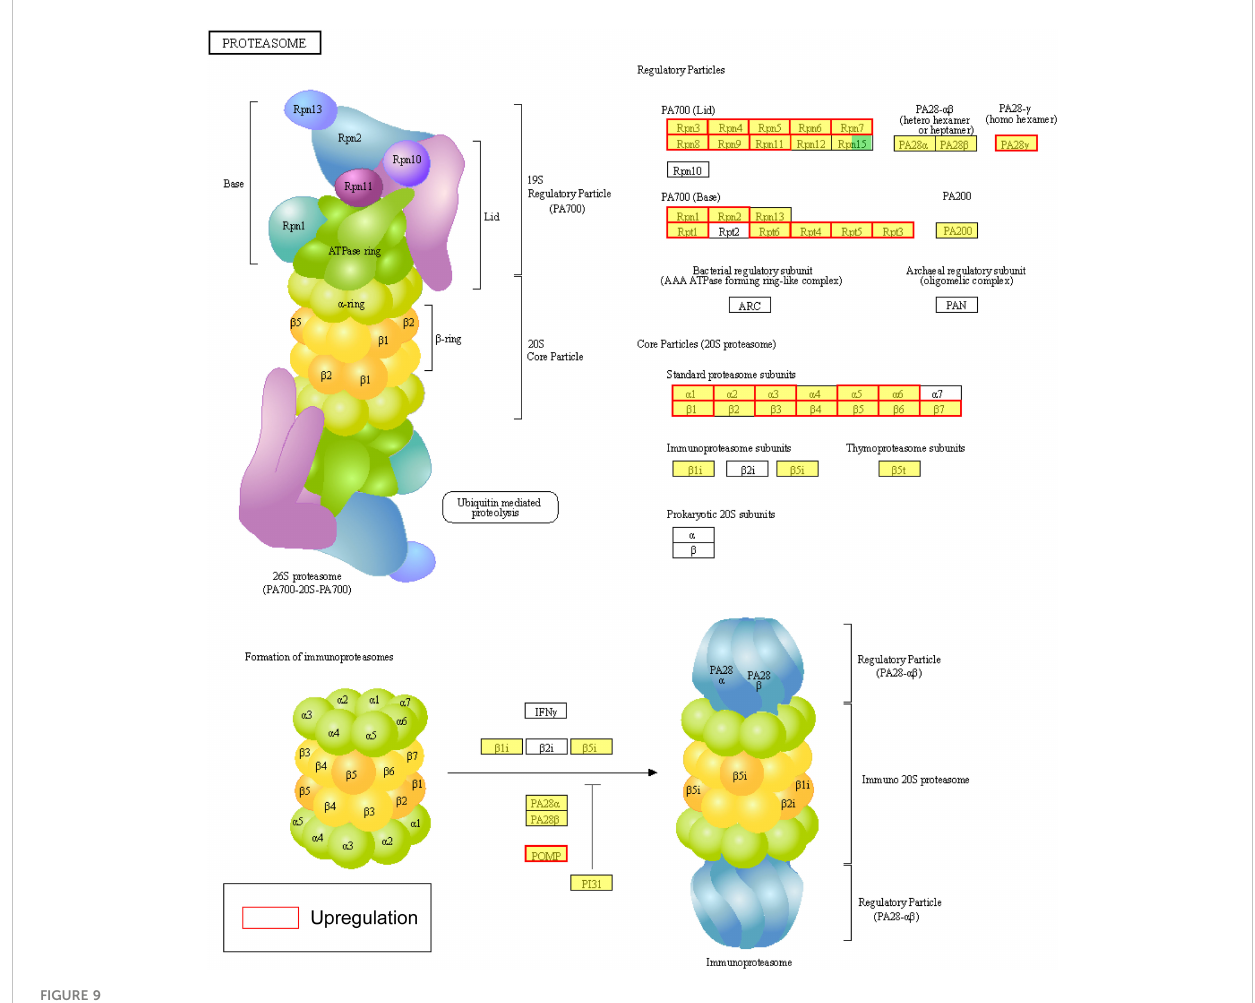
FIGURE 9 Changes of proteasome during LO vs